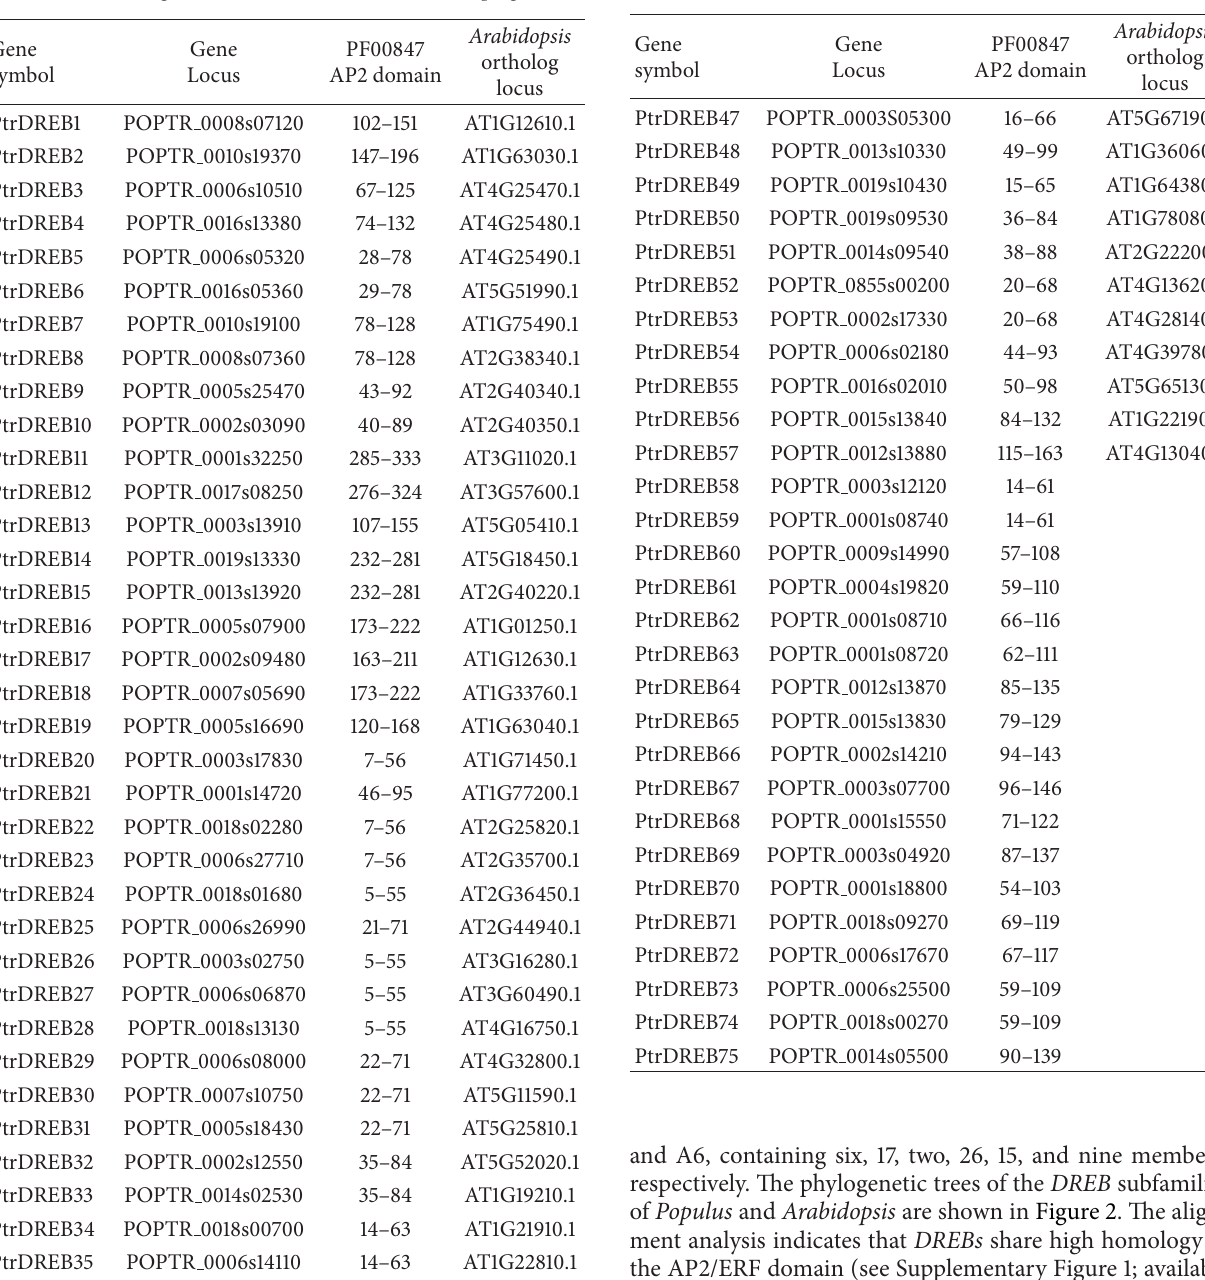
Table2:The DREB genesidentifiedfromthe P. trichocarpa